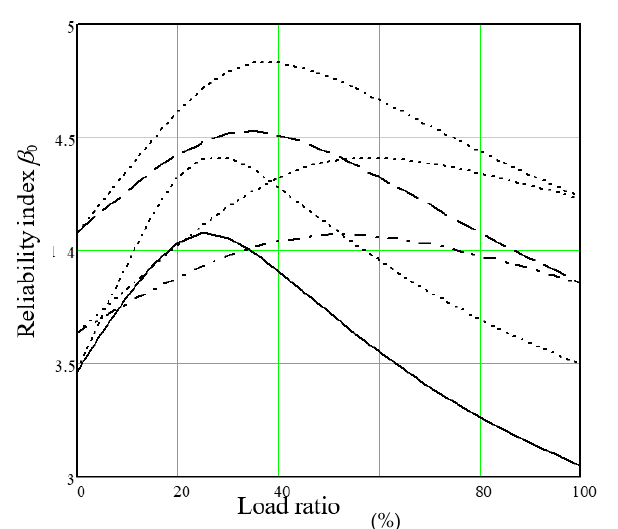
Figure 6. Reliability indexes as a function of the load ratio. Solid line, steel, γ M = 1.0; dashed line, γ M = 1.3, timber; and dash-dotted line concrete, γ M = 1.4. Dotted lines apply to the one-year calculation.